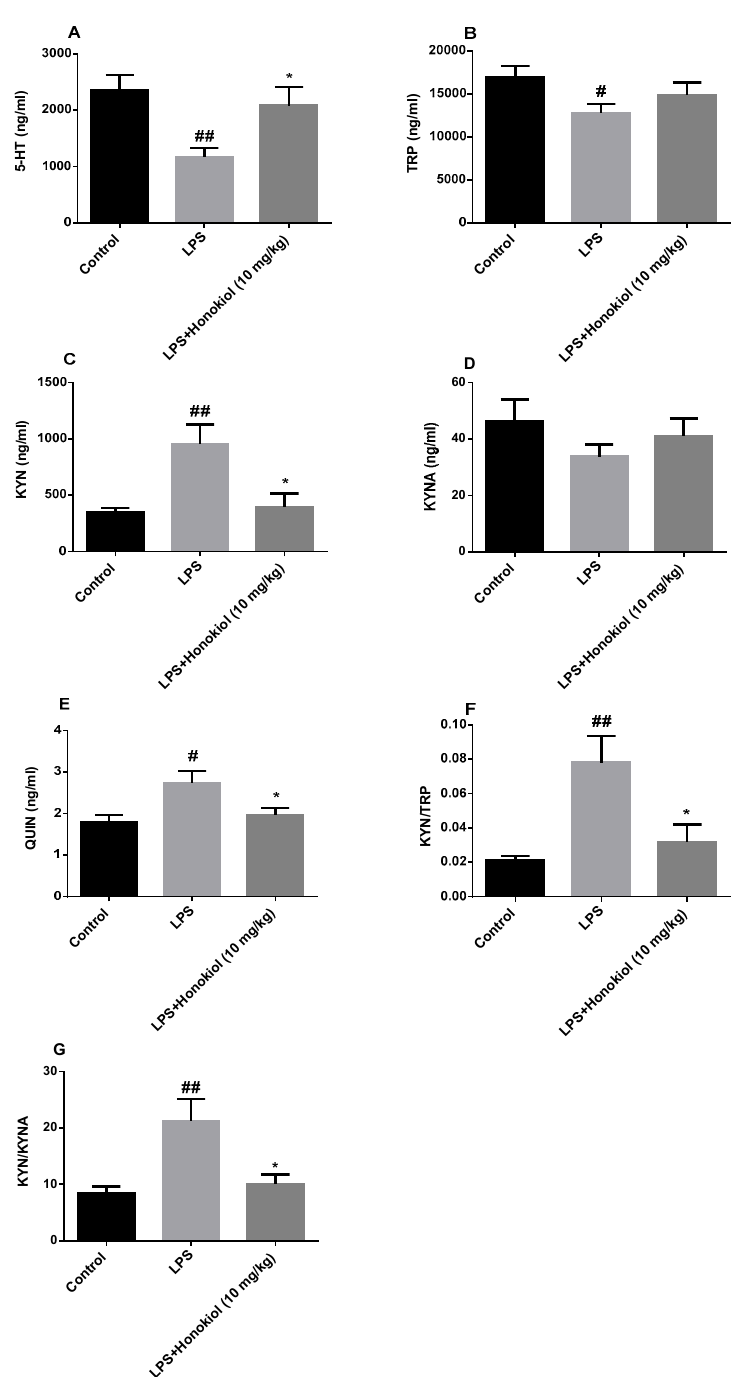
Figure 5. The e ff ects of honokiol on the metabolites of the tryptophan–kynurenine (TRP–KYN) pathway. ( A ) serotonin (5-HT); ( B ) TRP; ( C ) KYN; ( D ) kynurenic acid (KYNA); ( E ) quinolinic acid (QUIN); ( F ) KYN / TRP ratio; and ( G ) KYN / KYNA ratio. Data are expressed as mean ± SEM ( n = 5). ## p < 0.01, # p < 0.05 LPS vs. control; * p < 0.05 LPS + Honokiol vs. LPS.